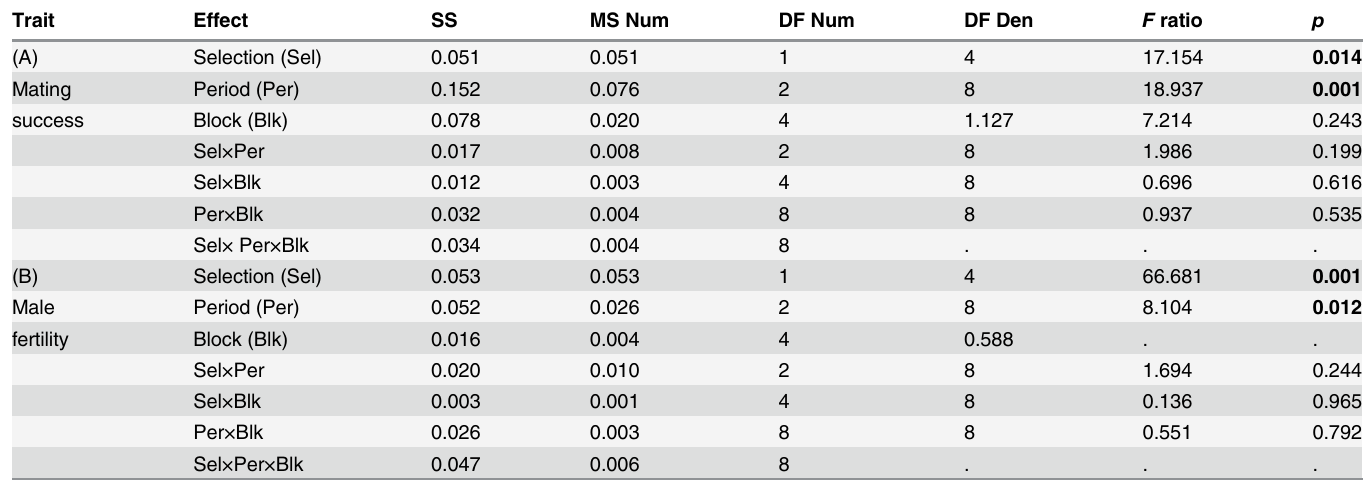
Table 2. Effect of cold shock on pre- and post-copulatory traits. Summary of results of a three-factor mixed model ANOVA considering selection regime (FSB and FCB) and period (recovery period 4, 12 and 30 hours after cold shock) as fixed factors crossed with block as random factor on the (A) mating suc- cess and (B) male fertility data. p -values in bold are statistically significant. Estimated denominator DF (Satterthwaite method) was very low. Hence F ratio and p values are unavailable for some of the effects. Trait